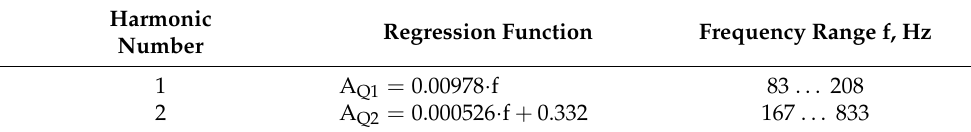
Table 3. Regression functions of the flow pulsation amplitudes in the experiment with the “infinitely long” pipeline.